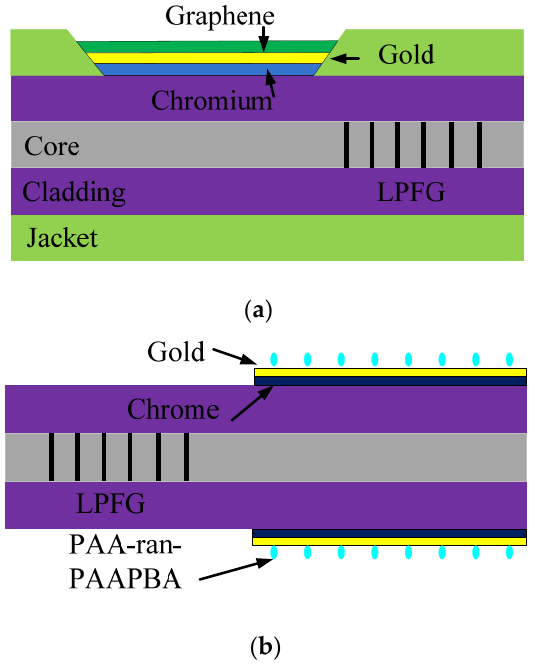
Figure 11. The description of the SPR sensors: ( a ) The jacket of LPFG is side-polished and coated with multilayer materials [49]; ( b ) LPFG sensor coated with chrome, gold, and the functional material [50].